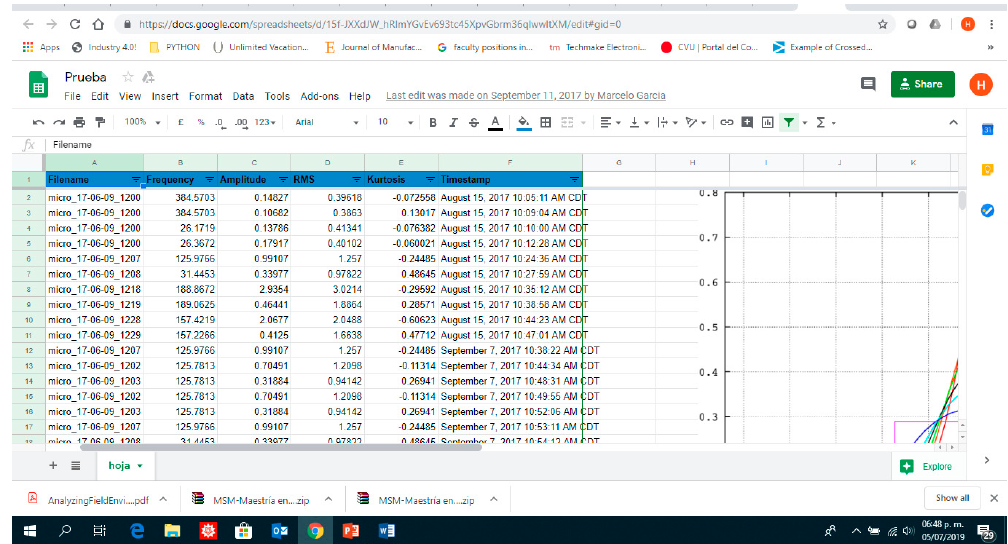
Figure A1. Prototype test result sheet uploaded to the cloud mentioned in Section 2.2 and Figure 12.